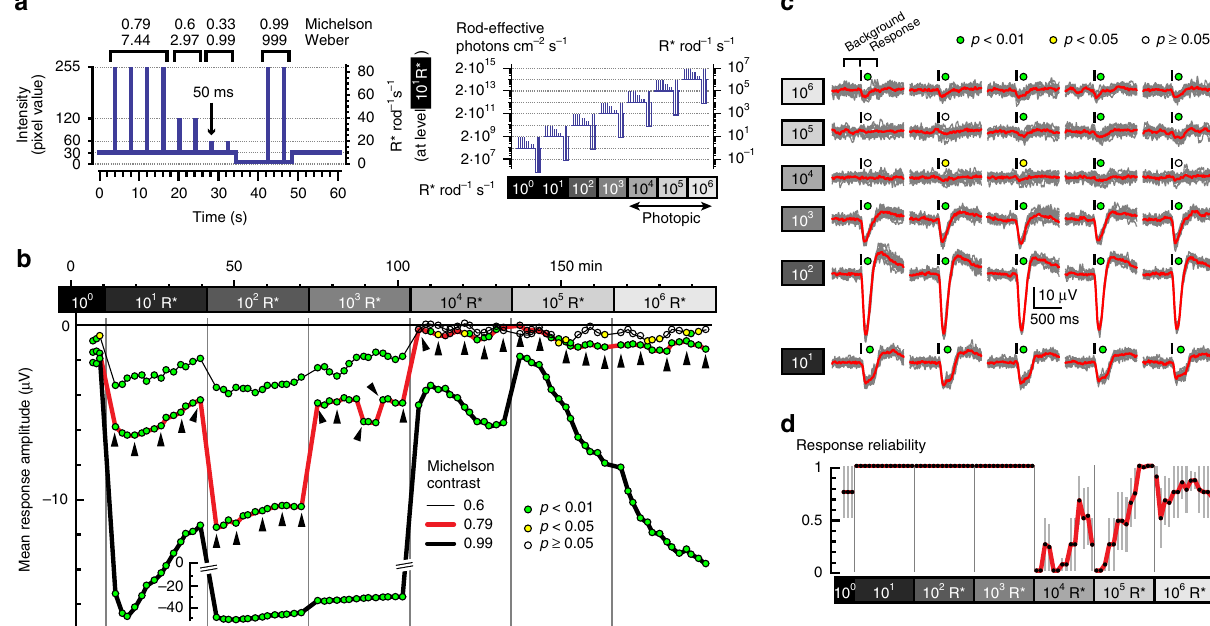
Fig. 1 Ex vivo ERG recordings from isolated Cnga3 − / − retina. a Stimulus used for ex vivo ERG recordings consisted of 50 ms fl ashes ranging from 0.33 to 0.99 Michelson contrast. Right: absolute stimulus intensities at different light levels. b , c Data from one representative retina. b Running average of the ERG response (baseline-corrected, i.e., mean negative voltage de fl ections in the 300 ms after fl ash onset, minus 300 ms before). Each data point shows mean from three consecutive stimuli (i.e., from 12 individual fl ashes for 0.79 Michelson contrast, and 6 fl ashes for the other contrasts; data for the weakest contrast is omitted for clarity). Neighboring data points are shifted by one stimulus. The color-coded disks indicate the level of signi fi cance of the response relative to the background activity (Wilcoxon rank sum test). The raw traces underlying the data points indicated by the triangles are shown in c (gray: individual responses; red: average of 12 responses; black bars above traces: timing of fl ash). d Response reliability of ERG responses